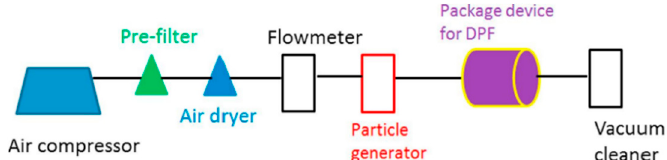
Figure 5. Schematic of the DPF loading system [74].